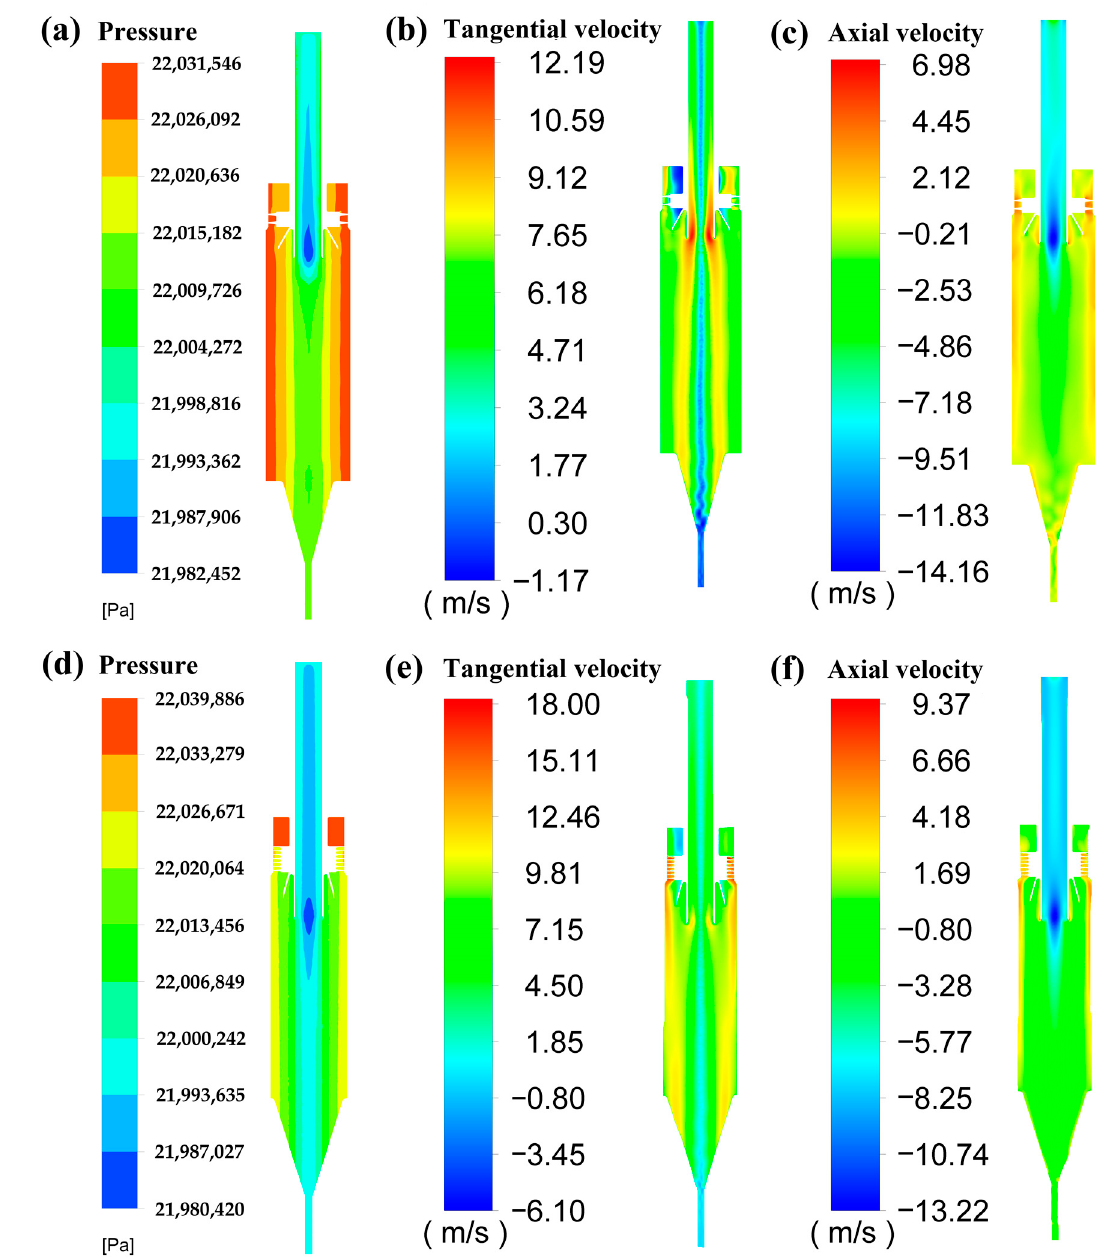
Figure 12. The contour of the original structure and the improved structure. From top to bottom: original structure and improved structure. From left to right: pressure contour, tangential velocity contour, and axial velocity contour.